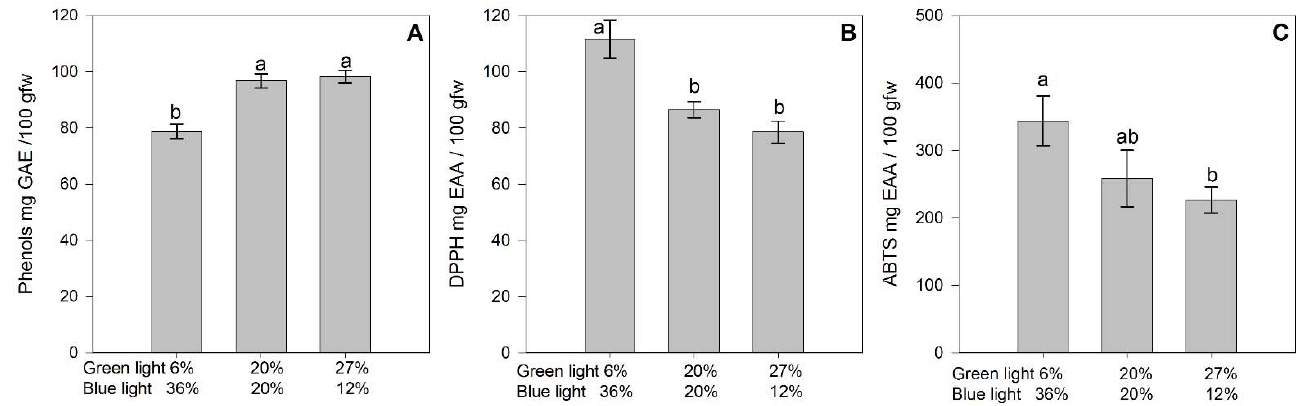
Figure 9. Effect of the green (500–600 nm) and blue (400–500 nm) light balance on phenols ( A ) and antioxidant capacity measured by DPPH ( B ) and ABTS ( C ) in fruits of strawberry plants grown in an indoor vertical system with LED lighting. Bars represent the standard error of the mean. Columns with different letters indicate significant differences according to Duncan’s multiple comparison test with p < 0.05.